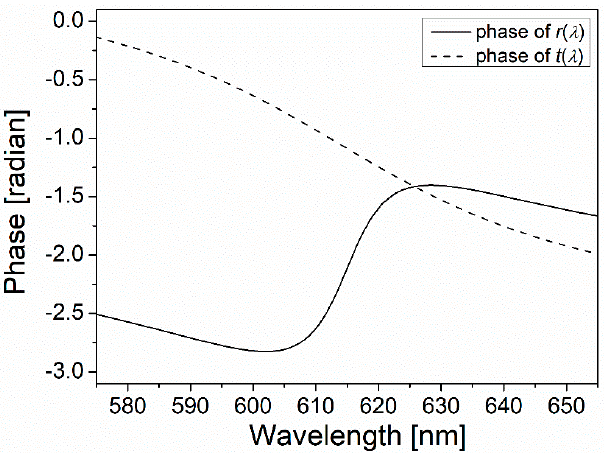
Figure 2. ( A ) The reflectance (cid:1844)((cid:2019)) ≡ |(cid:1870)((cid:2019))| (cid:2870) calculated by a field transfer matrix-based formula (Equation (1)), assuming the Kretschmann–Raether configuration where SPP is excited at the interface between the 50 nm-thick Au film and air. The incident angle ( (cid:2016) (cid:3036)(cid:3041) ) is 43.85° . The reflection dip occurs at a wavelength of about 615 nm. ( B ) The natural logarithm of 1/(cid:1844)((cid:2019)) where (cid:1844)((cid:2019)) is given by ( A ).